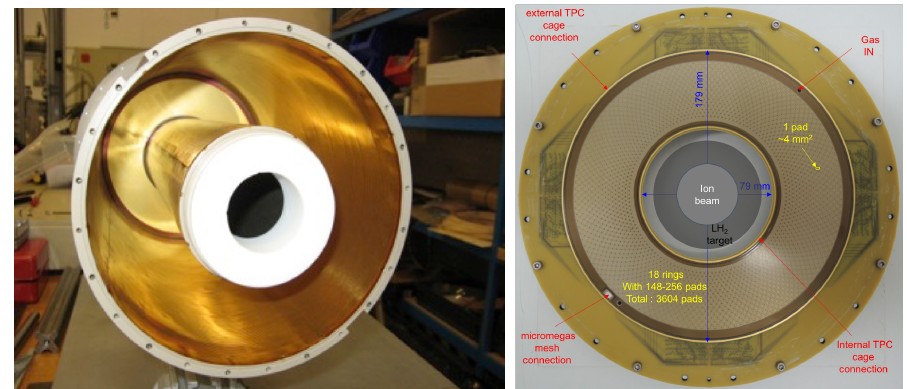
Figure 16. The MINOS